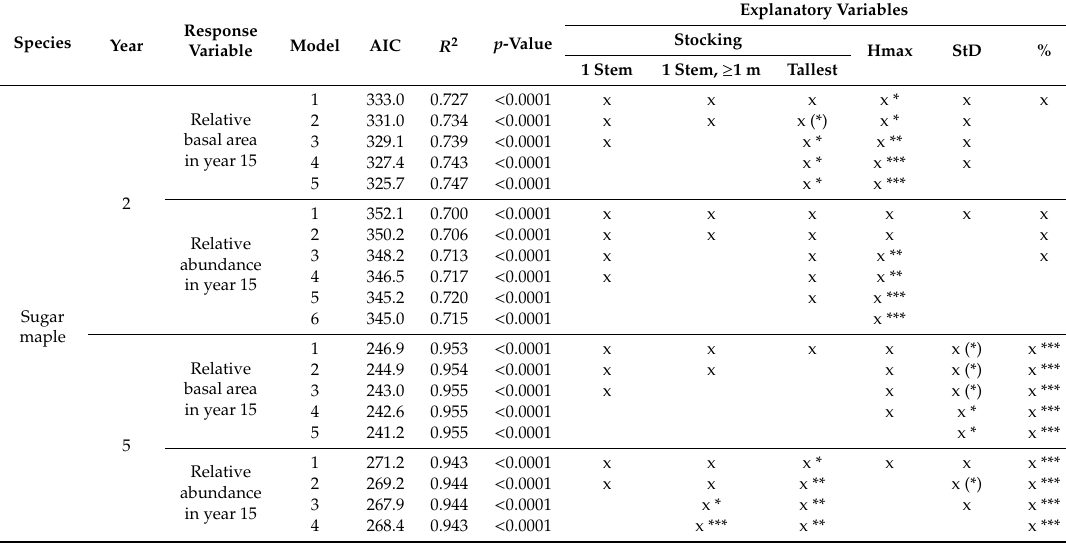
Table 4. Results of the model selection approach for sugar maple. Response variables were chosen from year-15 regeneration indices that represented relative presence of a species within a canopy opening. Explanatory variables comprised six regeneration indices (see Table 2), in year 2 and year 5 after harvest, selected according to preliminary correlations and to hypotheses based on forest dynamics. Previous tests had shown environmental variables as not, or barely, significant; hence their exclusion from these models. Stocking was computed on all seedlings and saplings, while stem density (StD) was computed on seedlings ≥ 1 m in height and saplings. Hmax, maximum height of target species per sampling